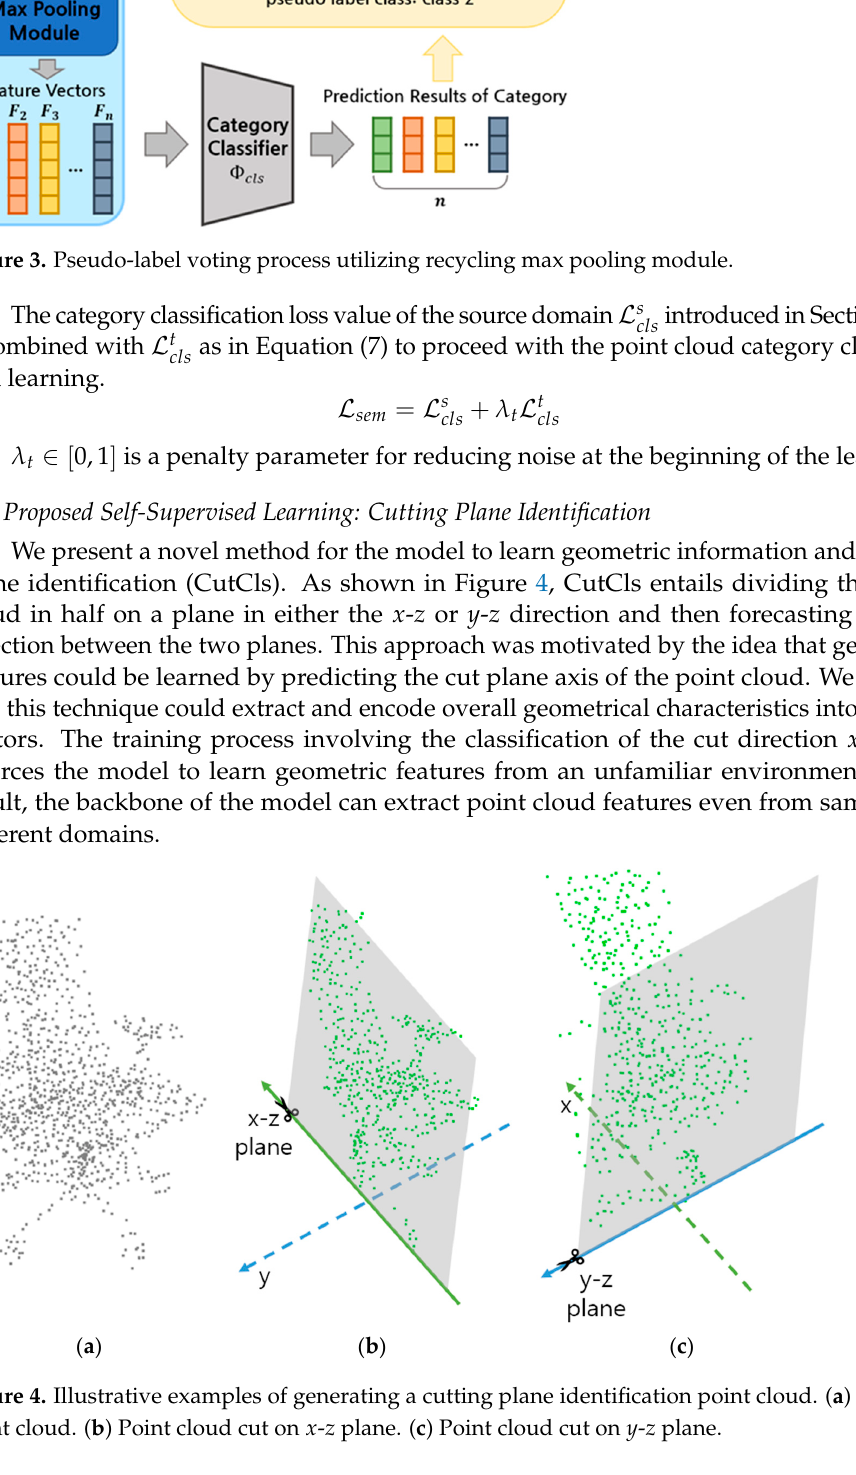
Figure 4. Illustrative examples of generating a cutting plane identification point cloud. ( a ) Original point cloud. ( b ) Point cloud cut on x - z plane. ( c ) Point cloud cut on y - z